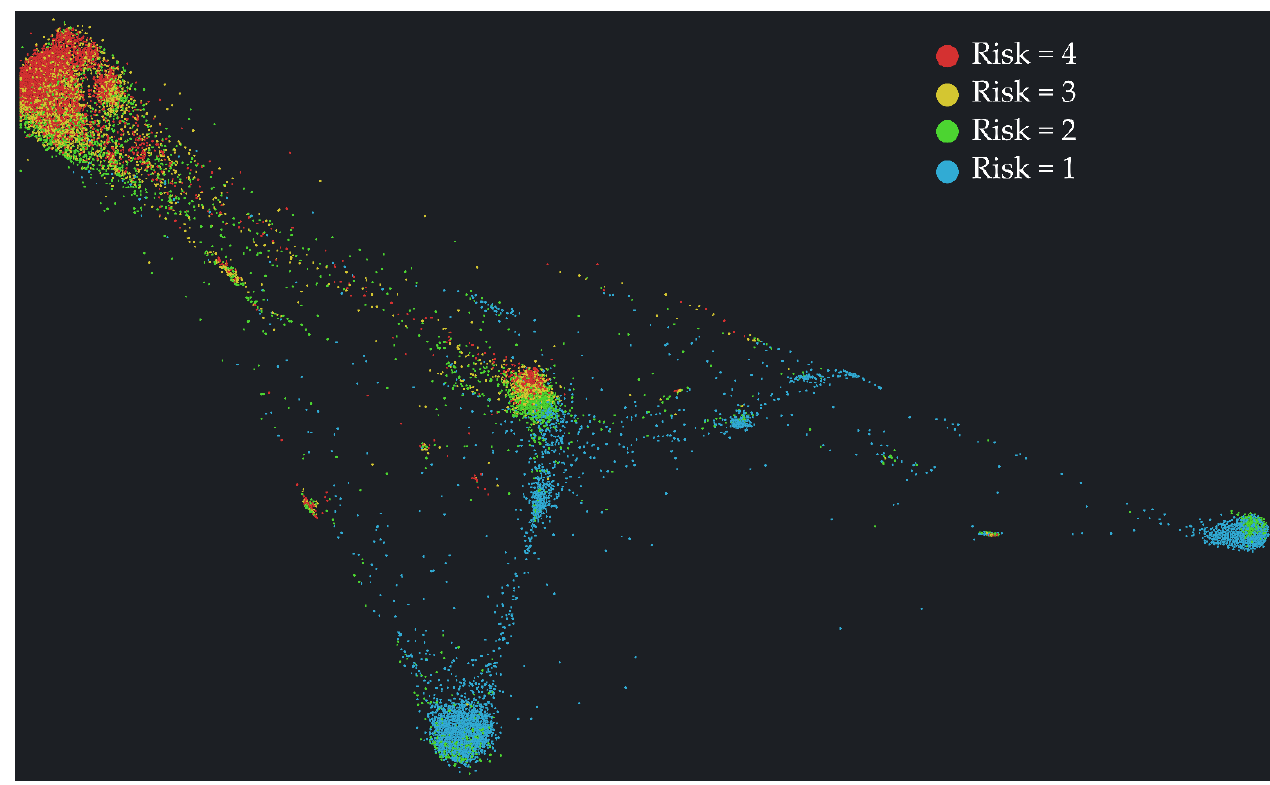
Figure 5. Network obtained illustrating the distribution of individuals based on the similarity values among them.